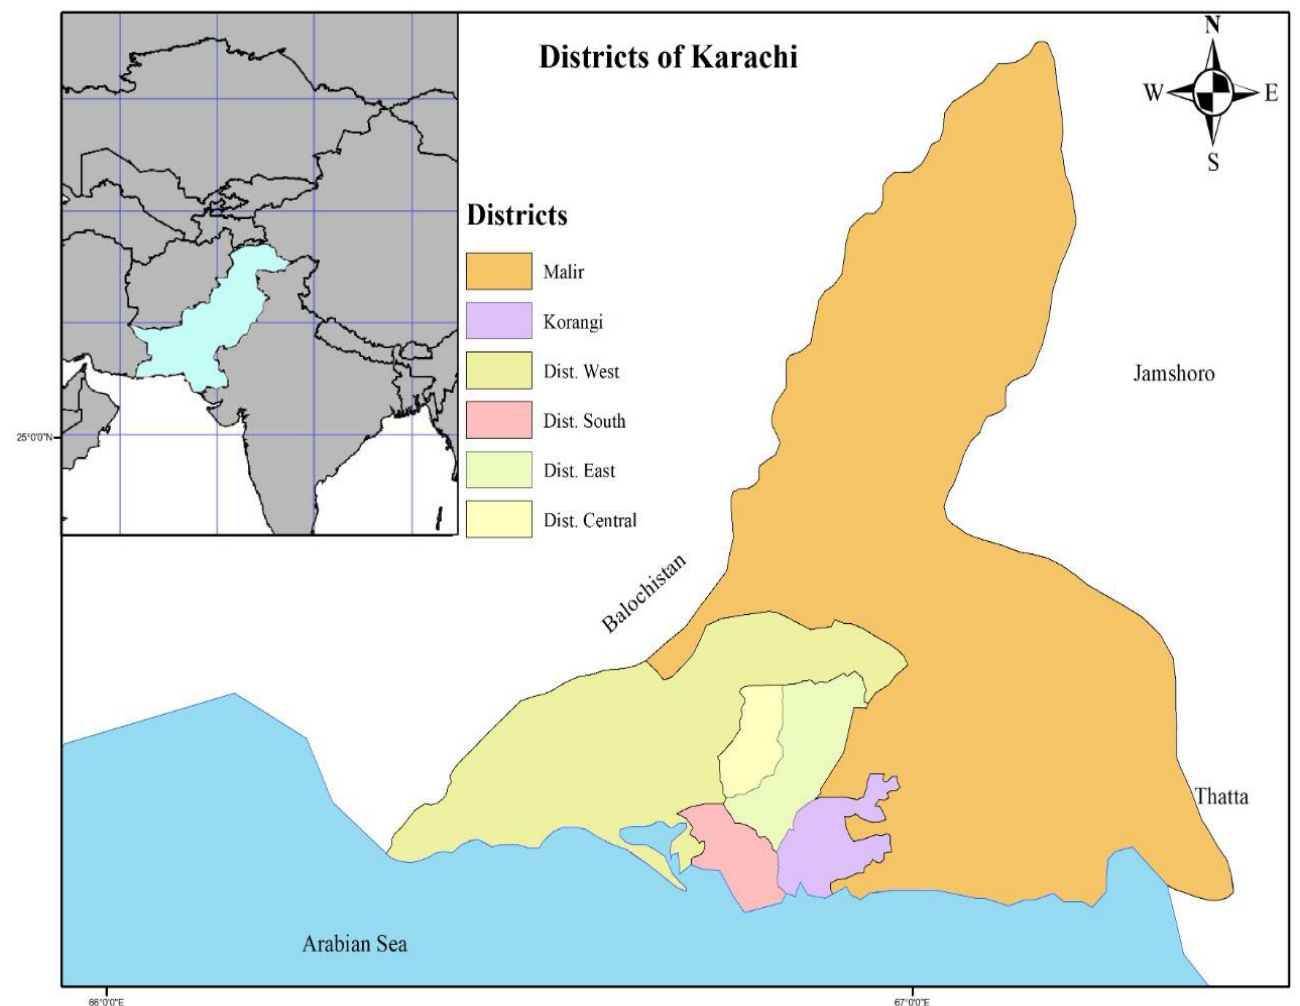
Figure 1. Districts of Karachi.